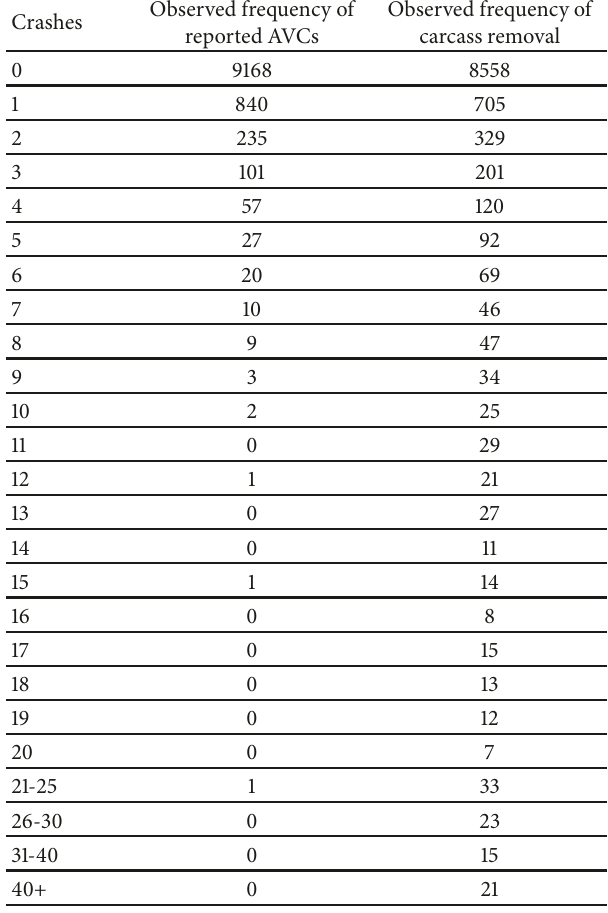
Table 2: Frequency distribution of reported AVCs and carcass removal in the Washington